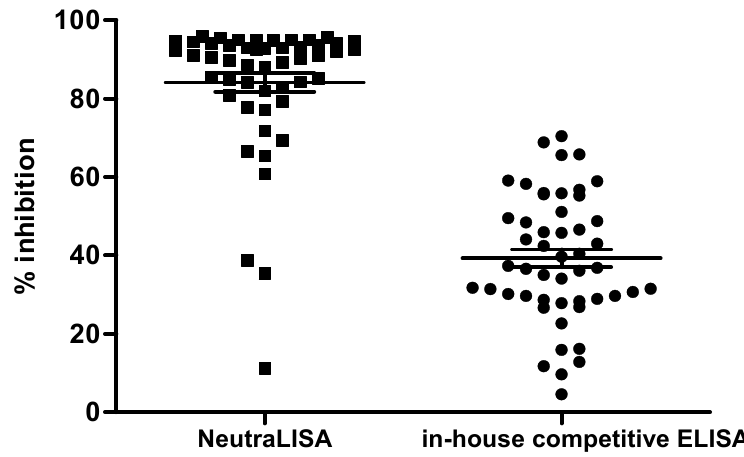
Figure 2. Comparison of the neutralizing antibodies against the RBD of SARS-CoV-2 in plasma samples collected at 14 days post 3rd vaccination with BNT162b2 by NeutraLISA and in-house competitive ELISA ( n = 50).